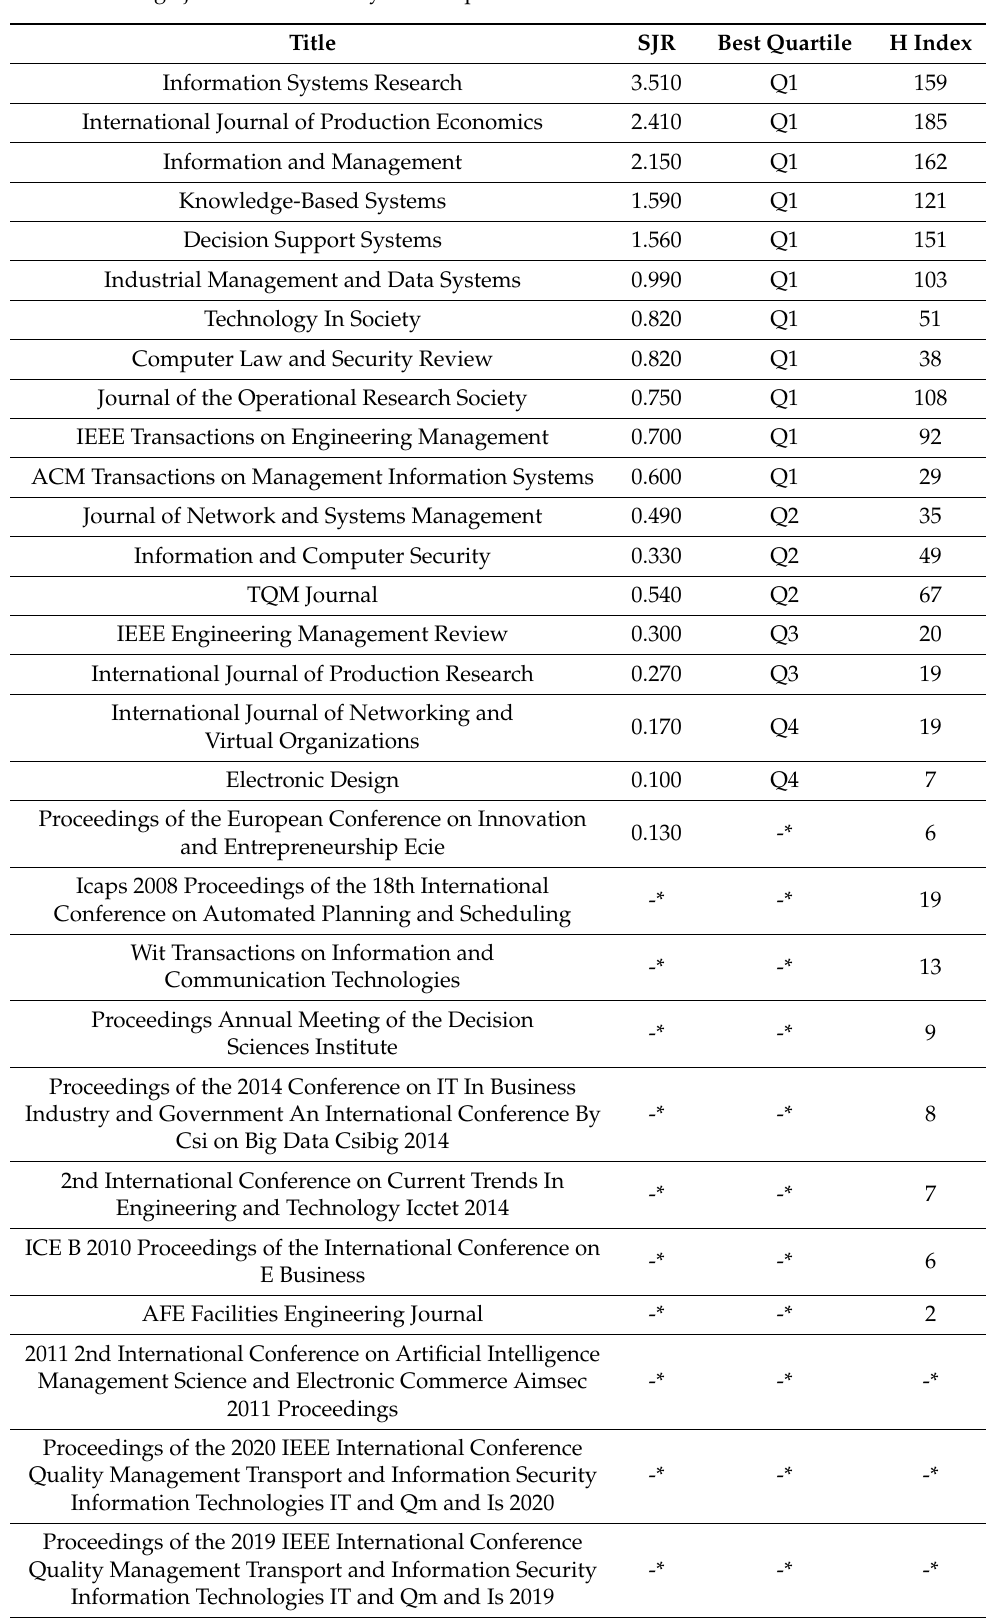
Table 2. Scimago journal and country rank impact